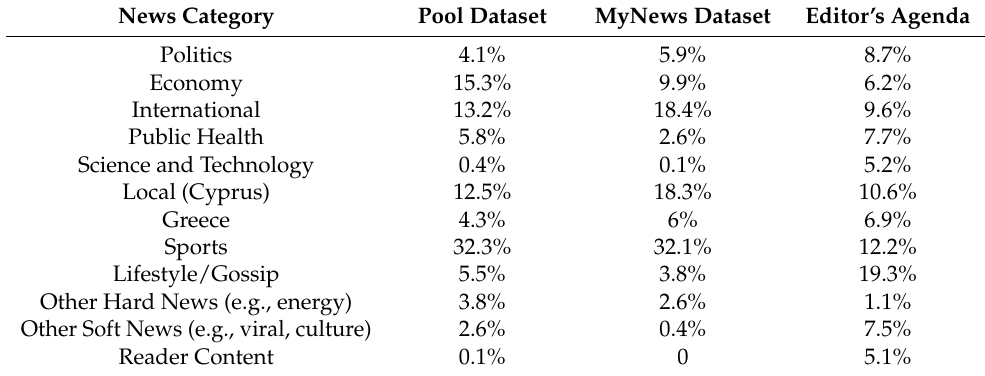
Table 3. Relative frequencies of news items categories in the three datasets (percentage within